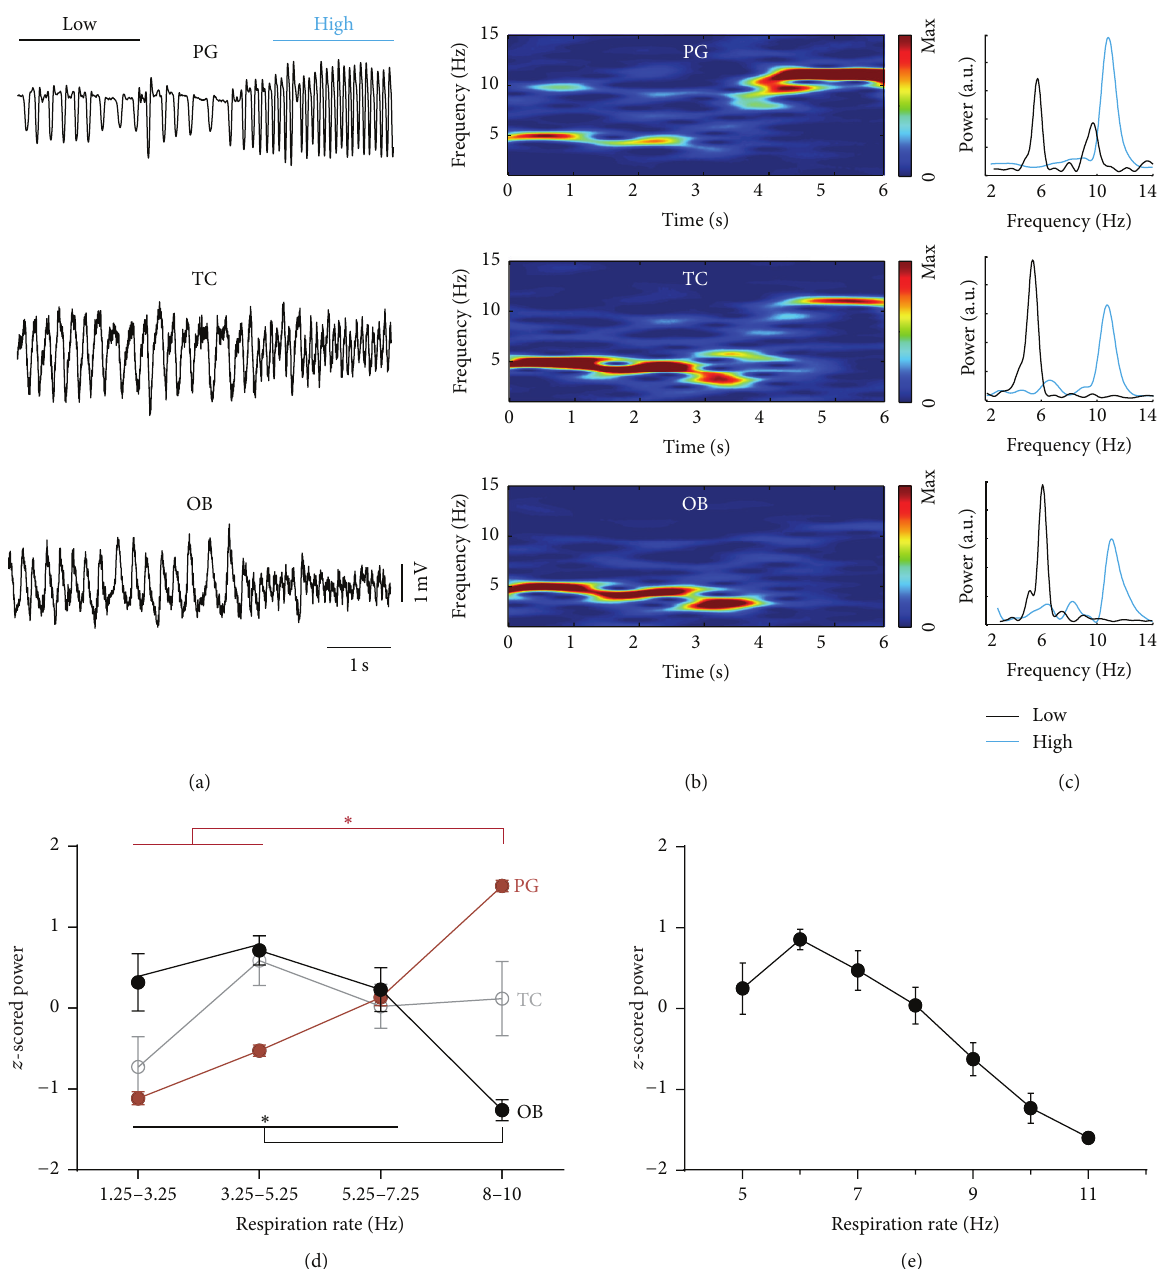
Figure 3: Breathing frequencies vary in freely moving animals. Transition from breathing to sniffing. (a) Raw signal. (b) Time-frequency distribution. (c) Power spectral density of the time periods indicated in (a). Power of olfactory bulb local field potential decreased with increasing respiration rate. (d) 𝑧 -scored peak power of plethysmography (PG, red; 𝑛 = 8 ; ∗ 𝑝 < 0.0005 ; Friedman’s test), thermocouple (TC, gray; 𝑛 = 8 ; 𝑝 = 0.22 ; repeated measures ANOVA), and LFP in olfactory bulb (OB, black; 𝑛 = 8 ; ∗ 𝑝 < 0.01 ; repeated measures ANOVA). (e) Negative correlation between OB peak power and respiration rate during running ( 𝑛 = 11 ; 𝑟 = −0.958 ; 𝑝 < 0.001 , Pearson’s correlation). Group results in (d) and (e) are shown as mean ± standard error of the mean (SEM).